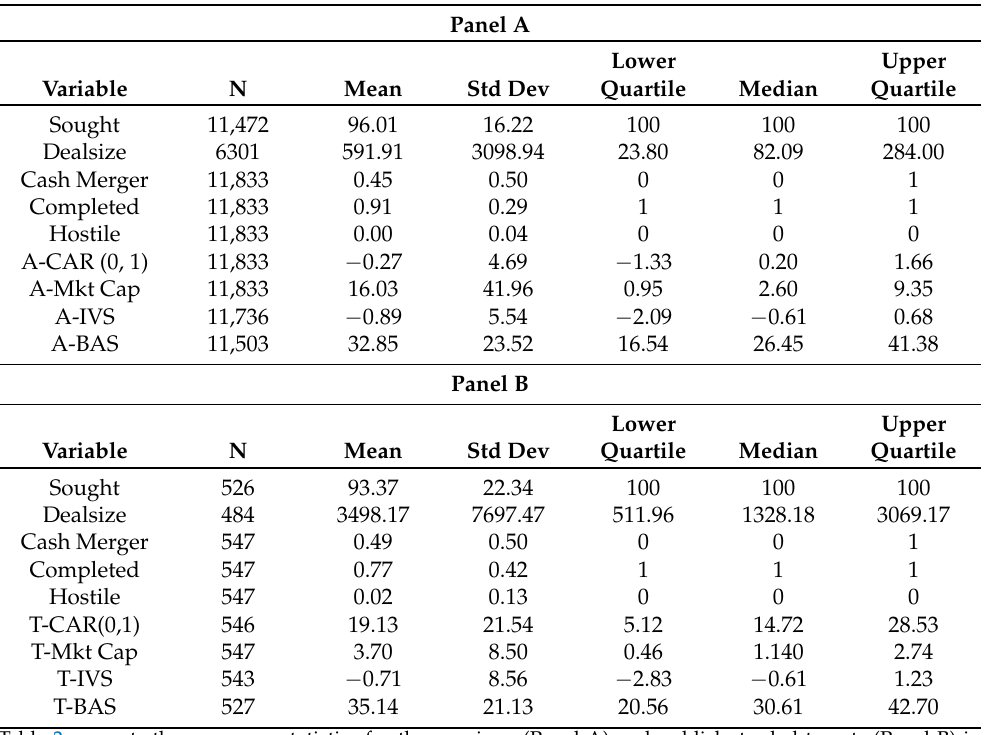
Table 2. Summary Statistics of M&A